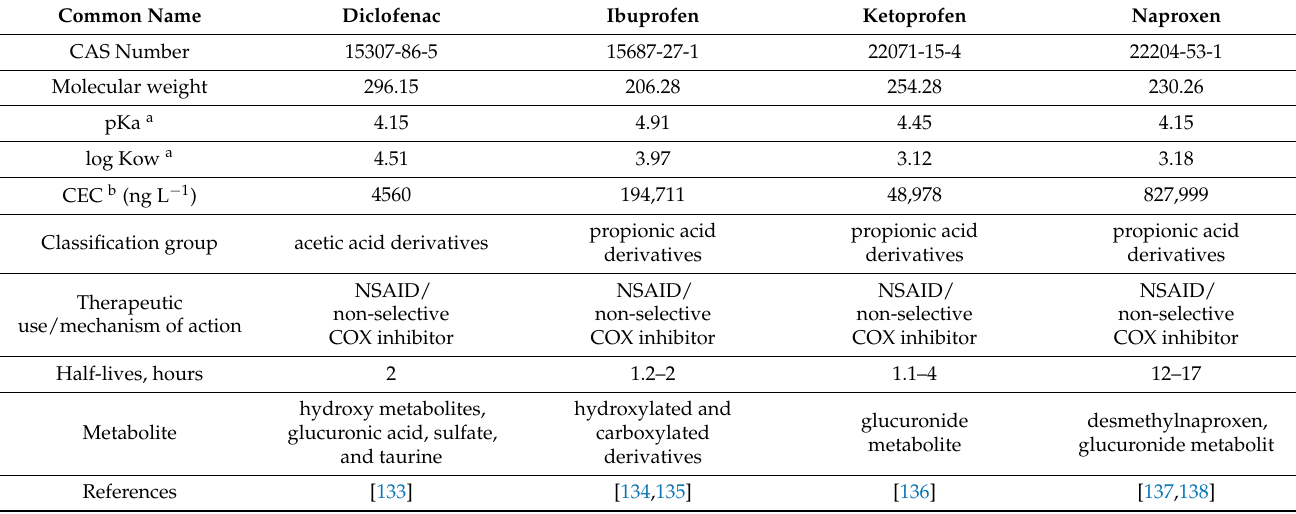
Table 3. Characteristics of the discussed NSAIDs.